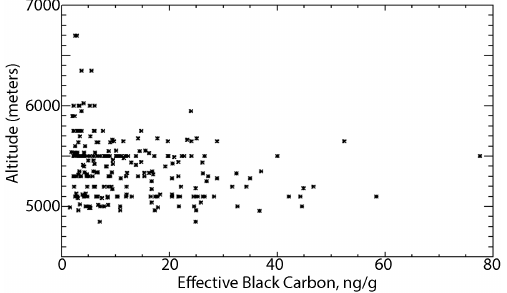
Figure 6. complete data set of eBC values determined from the LAHM analysis plotted versus altitude.